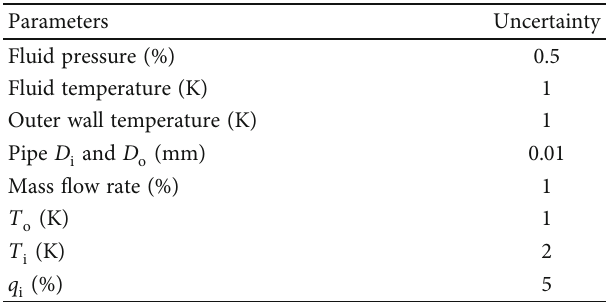
Table 2: Summary of the